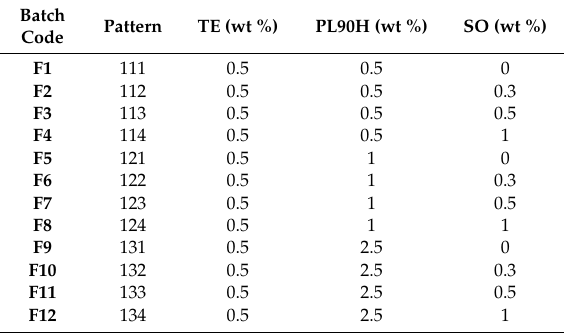
Table 2. Design of experiment (DoE) employed for the preparation of aqueous colloidal dispersions. Batch Pattern TE (wt %) PL90H (wt %) SO (wt Code